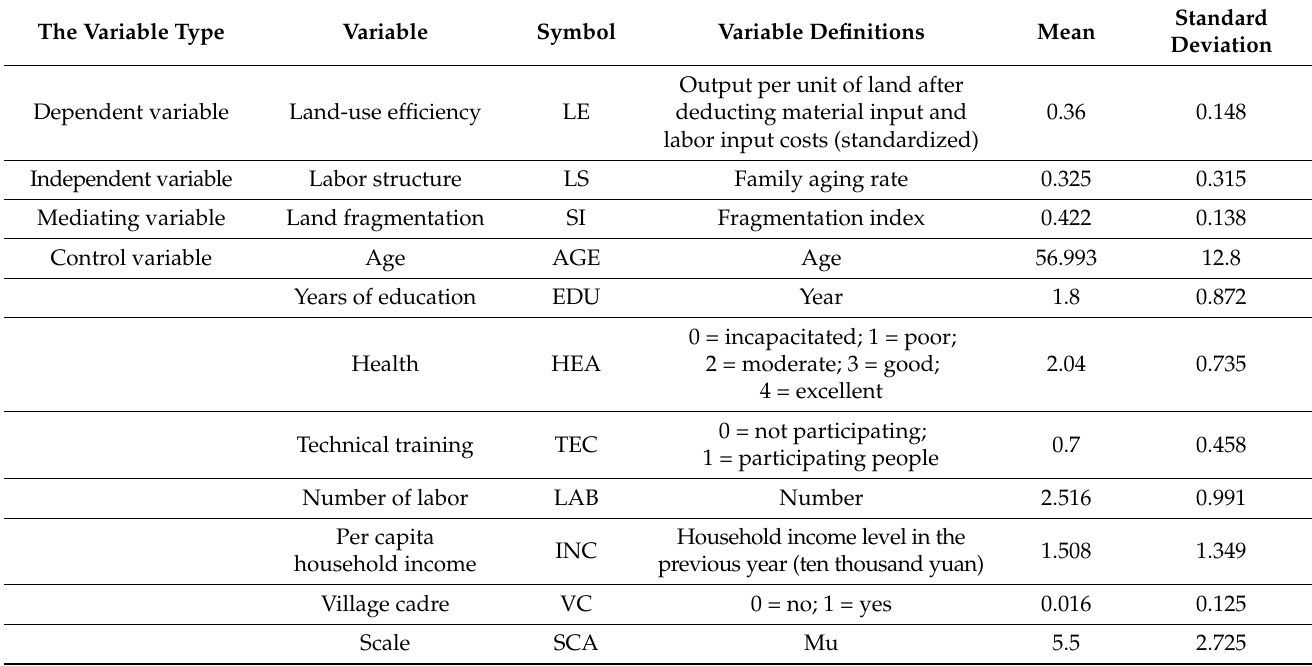
Table 1. Variable settings and descriptive